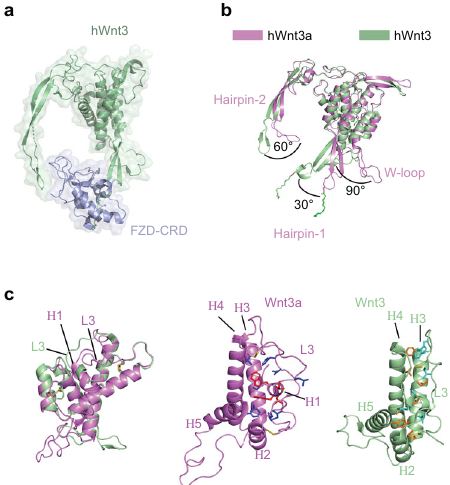
Fig. 4 Comparison between WLS bound Wnt3a and FZD-CRD bound Wnt3. a Structure of hWnt3 in complex with FZD-CRD 42 . b Superimposition of hWnt3a and hWnt3. c Comparison of N-terminal regions of Wnt3a and Wnt3. In left panel, N-half regions are isolated from superimposition result of Wnt3a and Wnt3. In right panel: For Wnt3a, residues of H1 are colored in red and shown as sticks, and interacting residues are colored in blue. For Wnt3, residues of L3 are colored in cyan and shown as sticks, and interacting residues are colored in orange. Disul fi de bonds are shown as